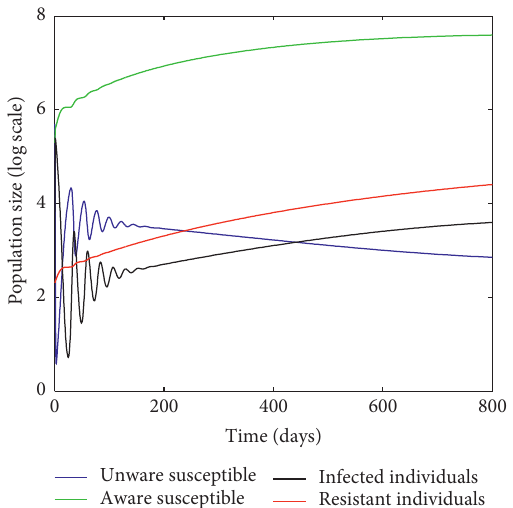
Figure 5: Time series global stability of the endemic steady state with initial state variables S ∗ values ξ � 0 . 003 , m � 0 . 2 , p � 0 . 02 , τ � 0 . 027, and Φ � 0 . 6; the remaining parameter values are specified in Table 1.